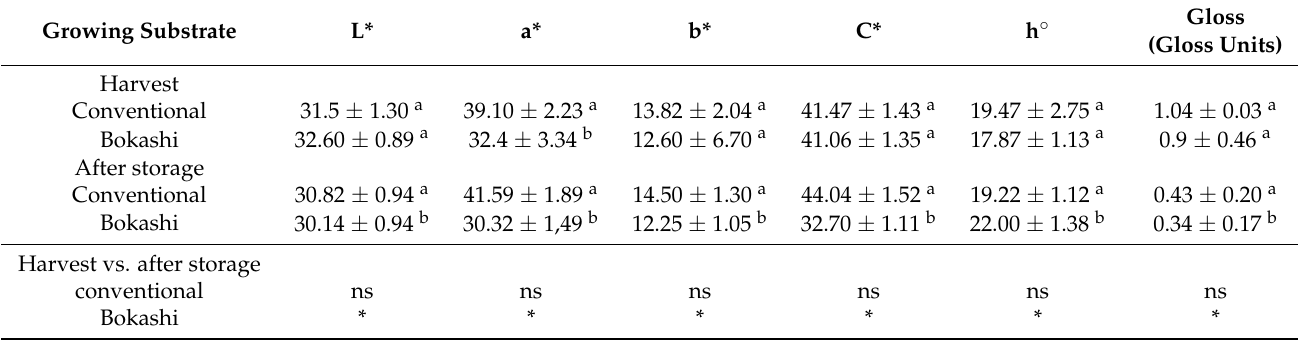
Table 5. Color attributes of bell peppers obtained from conventional and bokashi hydroponics at harvest and after storage for 14 days at 7 ◦ C and 95% relative